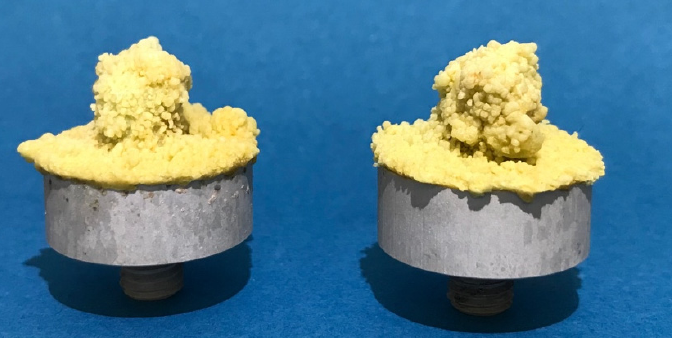
Figure 6. Already implanted test implants with cement after removal of all organic components.